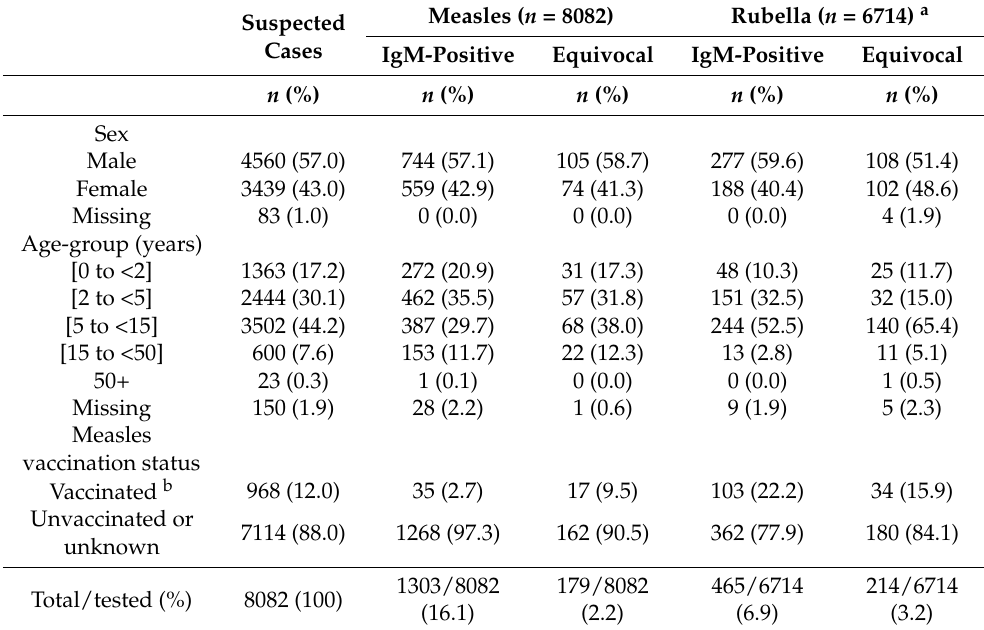
Table 1. Sex, age and vaccination status of suspected, IgM-positive and equivocal cases of measles and rubella in Senegal,